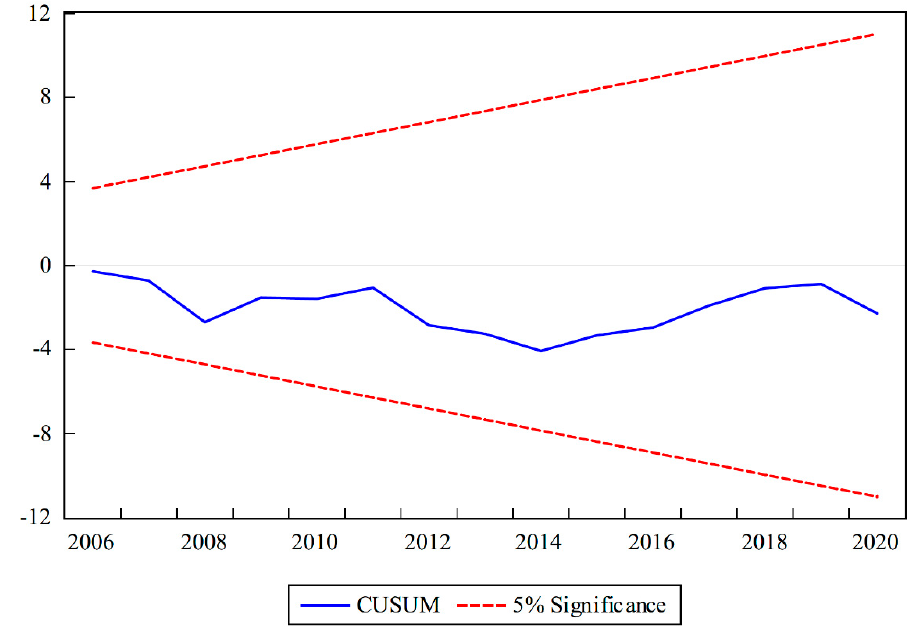
Figure 4. The plot of the cumulative sum of recursive residuals (CUSUM). The dashed lines are critical boundaries at 5% significance level.